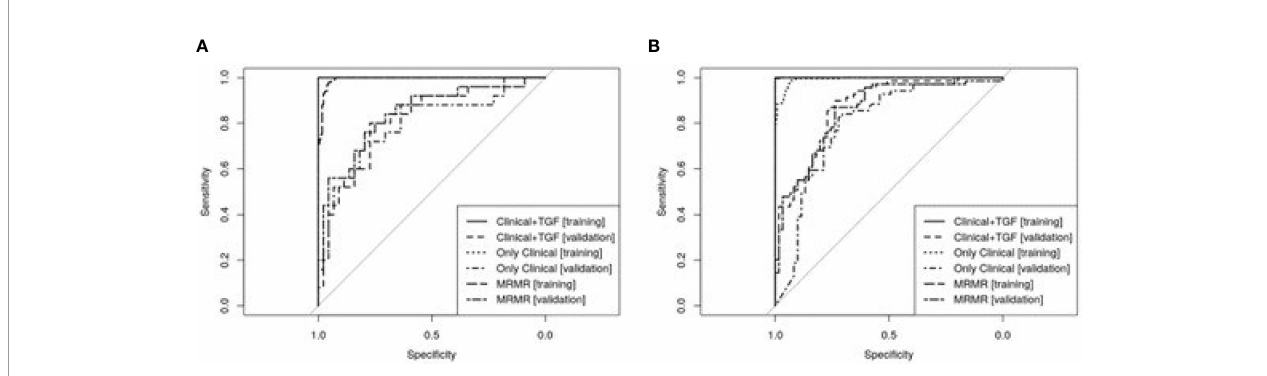
Supplementary Table 1 | Table showing the r-squared and p-values of pairwise linkage disequilibrium analysis. Supplementary Figure 1 | The fi gure presents an example of a mass spectrum for 20 analyzed SNPs in sample no. 524. The graph shows loci of all extend primers and possible alleles in different colors. The mass is expressed in daltons (Da). Supplementary Figure 2 | Mass spectra showing various alleles of rs2009112 polymorphism for selected samples: (A) The graph presenting the intensity of mass spectra for T homozygote, lack of signal for C allele; (B) The graph presenting the intensity of mass spectra for CT heterozygote; (C) The graph presenting the intensity of mass spectra for C homozygote, lack of signal for T